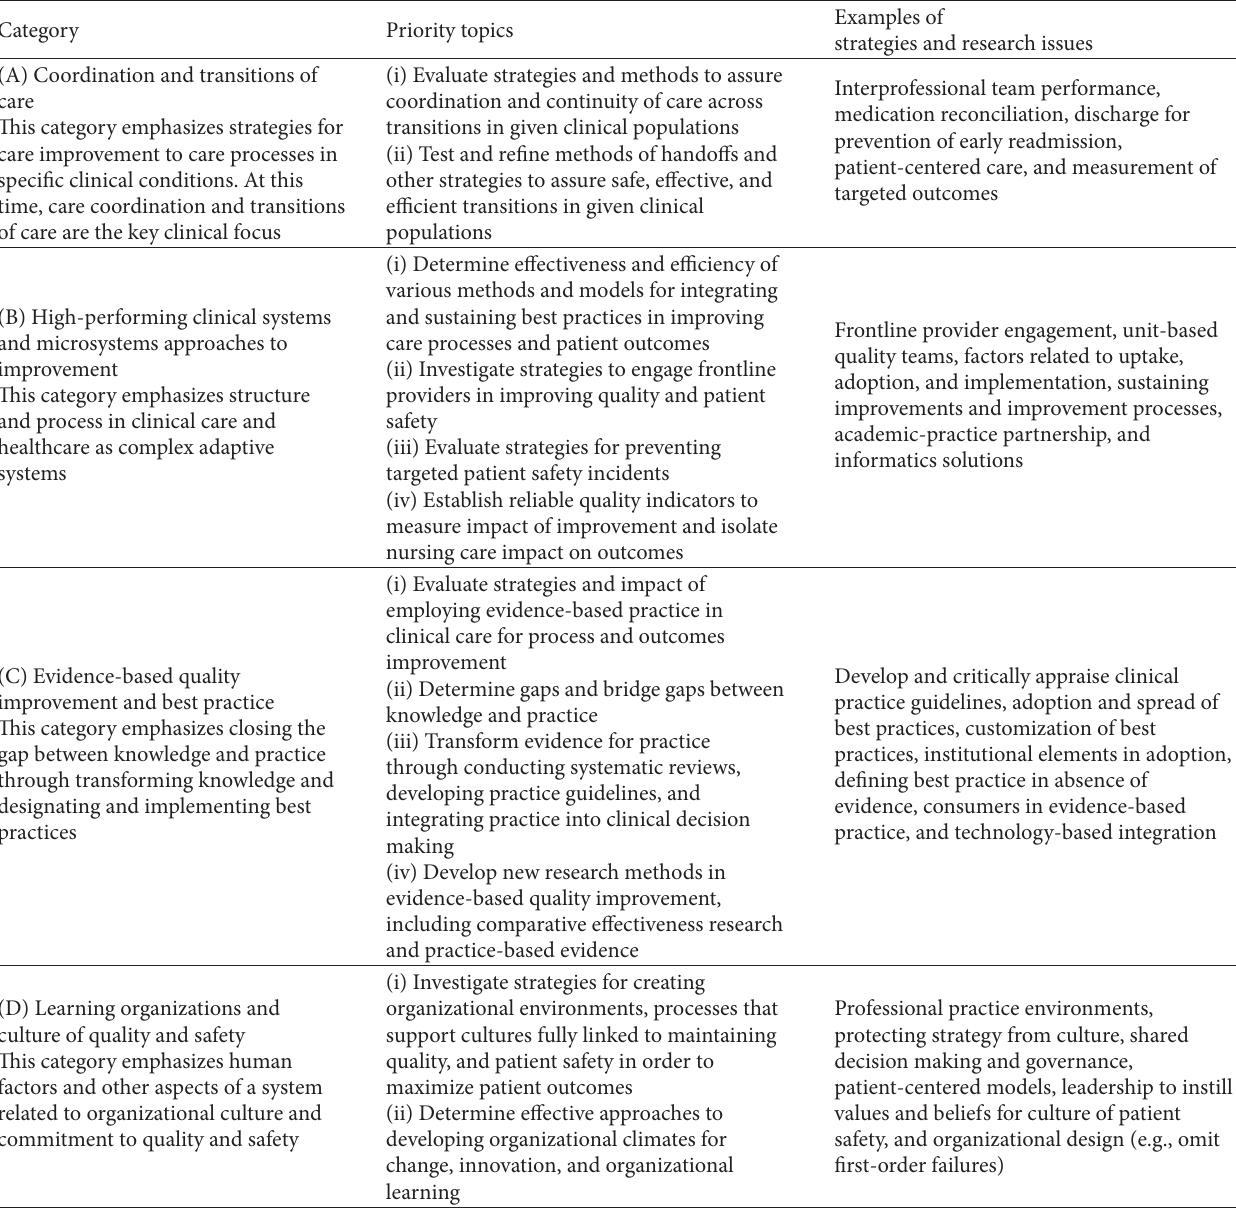
Table 5: National improvement research